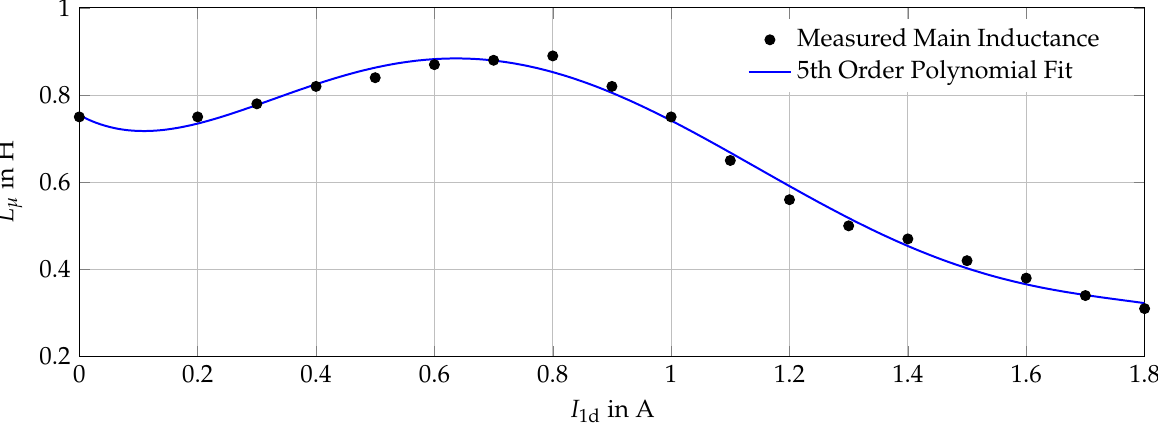
Figure 2. Measured main inductance values and polynomial fit to these